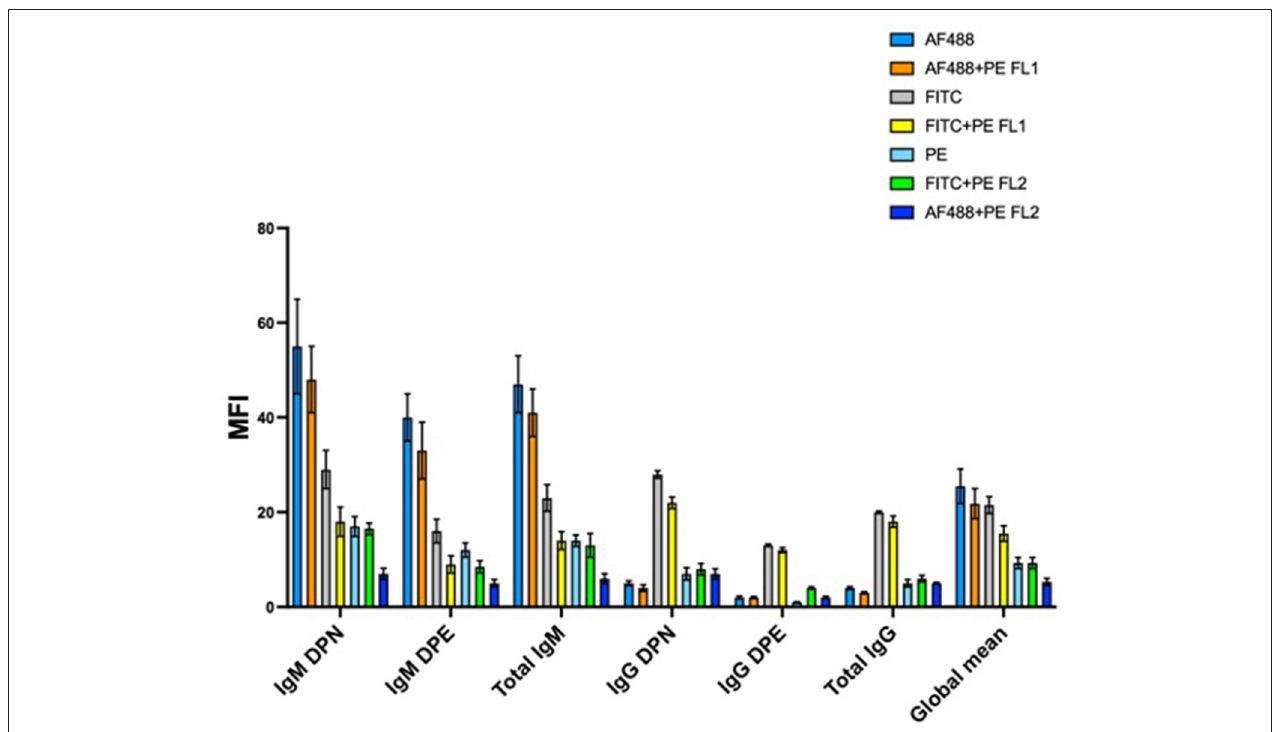
FIGURE 4 | Mean separation of double population of erythrocytes for 10 mixtures prepared at 5% of the donor and stained with different fluorochromes and/or combination of fluorochromes. AF488, AlexaFluor 488; PE, phycoerythrin; FITC, Fluorescin isothiocyanate; FL1, flow cytometer detector 1 (522nm); FL2, flow cytometer detector2 (585nm); DPN, double population recipient non-expressing the antigen; DPE, double population recipient expressing the antigen. Subclass IgM antigens were big C, small c, big E, Jka, and Jkb, while subclass IgG antigens were Fya, Fyb, and big